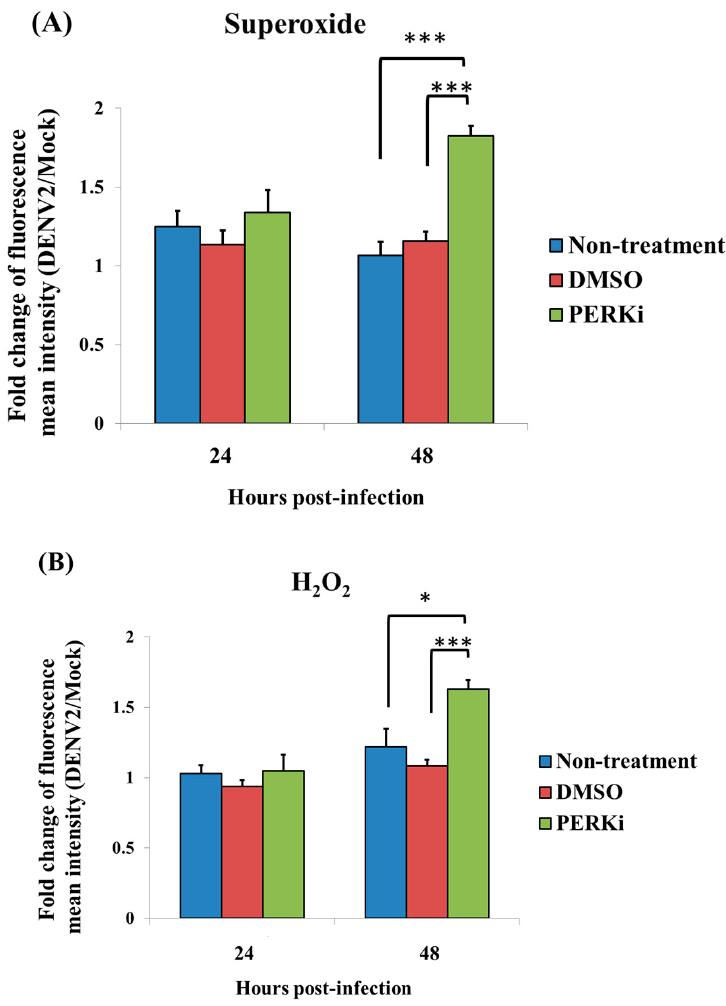
Figure 6. The PERK signaling pathway is involved in generating reactive oxygen species (ROS) accumulation in C6/36 cells with dengue 2 virus (DENV2) infection. Superoxide anions (O 2 − ) are one of the main ROS and are usually converted to hydrogen peroxide (H 2 O 2 ). ( A ) Using FACScan flow cytometry to detect the relative fluorescent intensity, superoxide anions exhibited no obvious change in cells with DENV2 infection (MOI = 1) at 24 h post-infection (hpi; 1.34-fold) even though a PERK inhibitor (5 µ M) was applied. A significant (1.82-fold) increase in superoxide anions was measured at 48 hpi, compared to those in the control groups (1.07-fold for the untreated and 1.16-fold for the DMSO-treated group; Student’s t -test; *** p < 0.001); ( B ) There was a similar changing trend in hydrogen peroxide in the same cell groups, leading to a significant increase at 48 hpi (1.63-fold; Student’s t -test; * p < 0.05, *** p < 0.001), but not at 24 hpi, (1.05-fold).